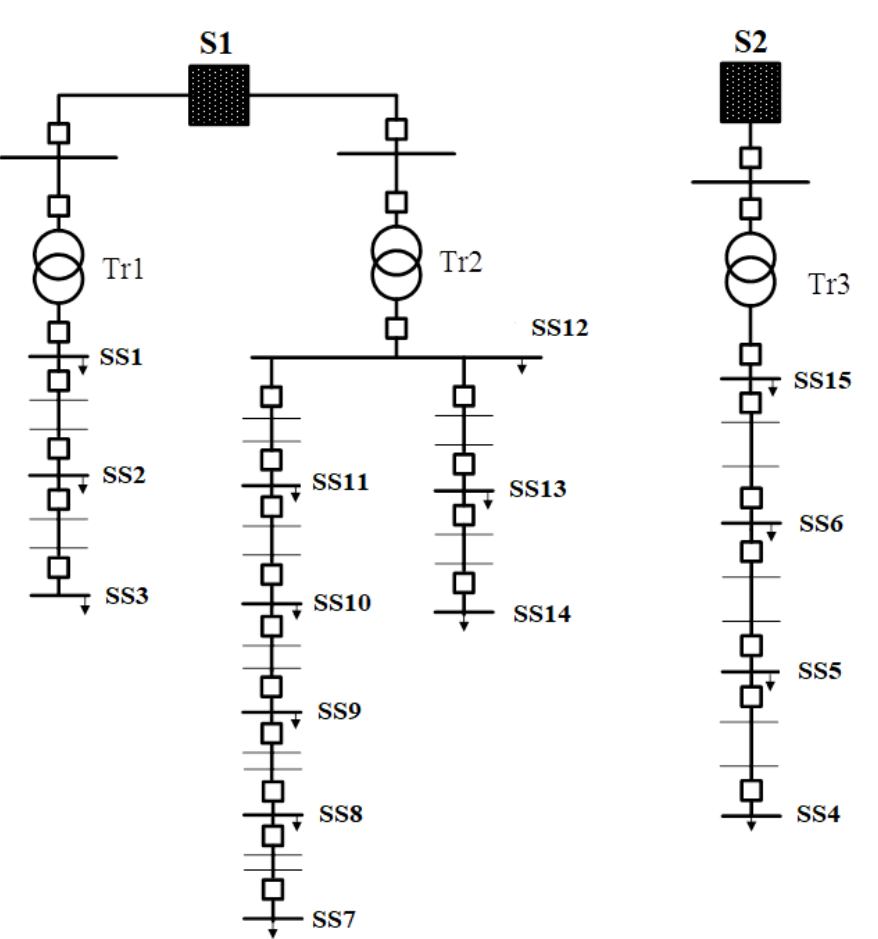
Figure 2. The initial structure of the power distribution network.